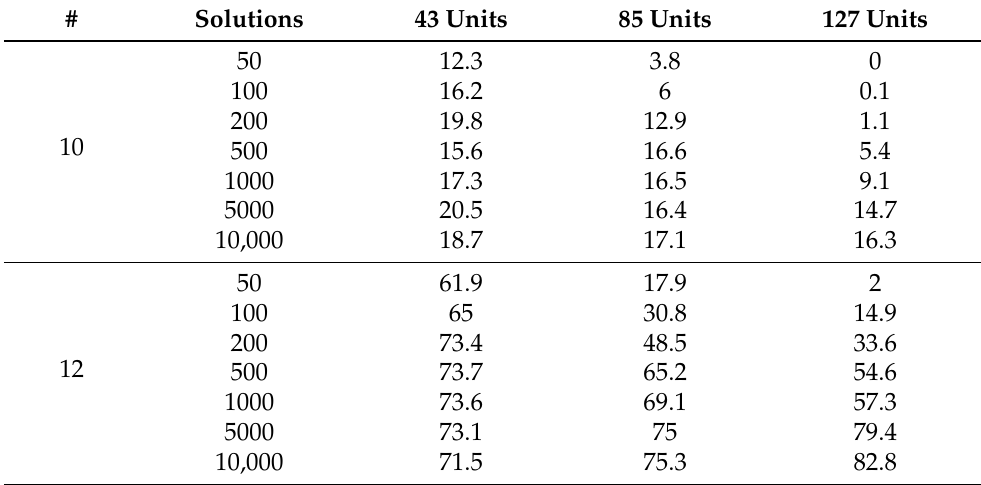
Table 5. Percentage of improvement obtained by the use of the second phase of the proposed procedure (number of districts generated, column